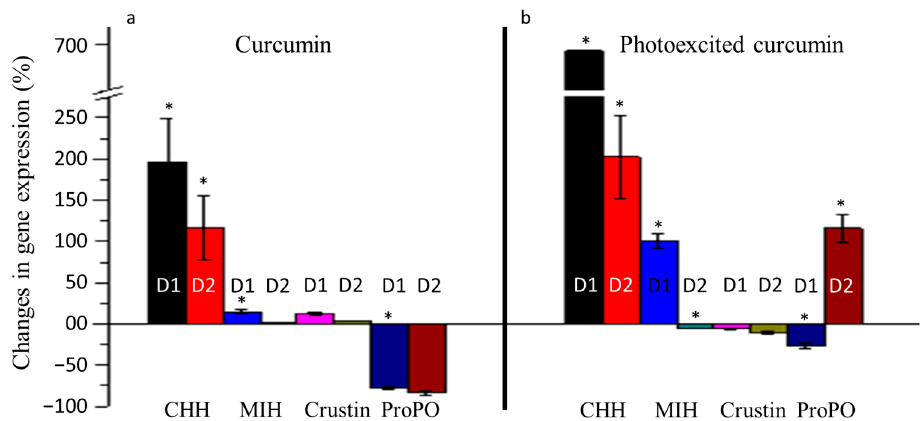
Figure 5. Changes in the expression levels of neuroendocrine (CHH, MIH) and immune (Crustin and ProPO) genes of Penaeus monodon larvae on exposure to curcumin and photoexcited curcumin. Samples were analysed one (D1) and two (D2) days after exposure to curcumin ( a ) and photoexcited curcumin ( b ). The differences observed between both treatment groups are statistically significant (marked as *, p < 0.05).